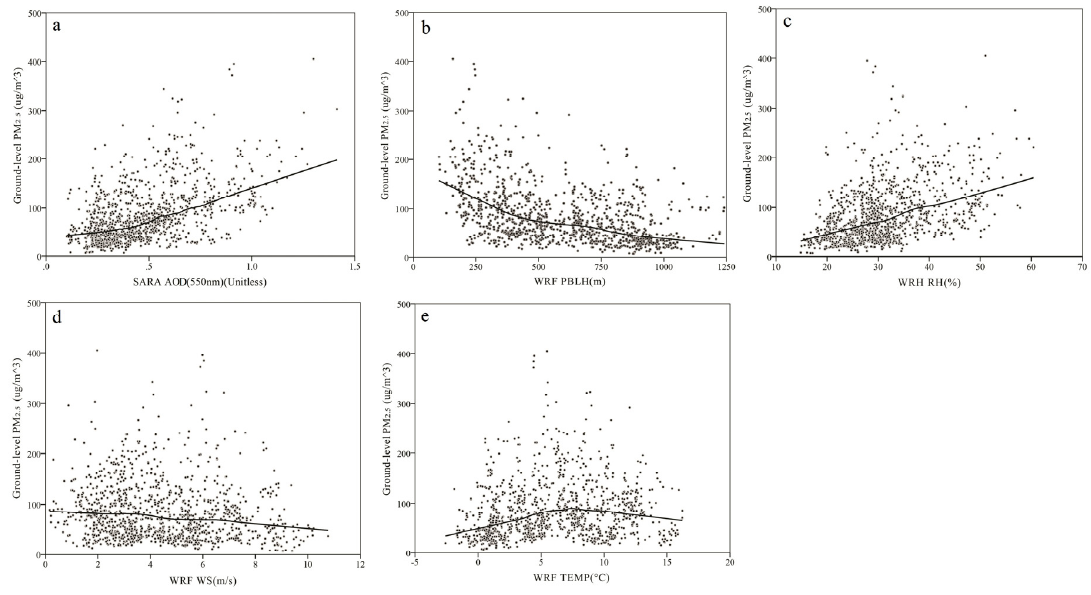
Figure 3. Scatter plots of the meteorological fields (( a ) SARA AOD; ( b ) WRF PBLH; ( c ) WRF RH; ( d ) WRF WS; and ( e ) WRF TEMP) against the hourly ground level PM 2.5 concentration.